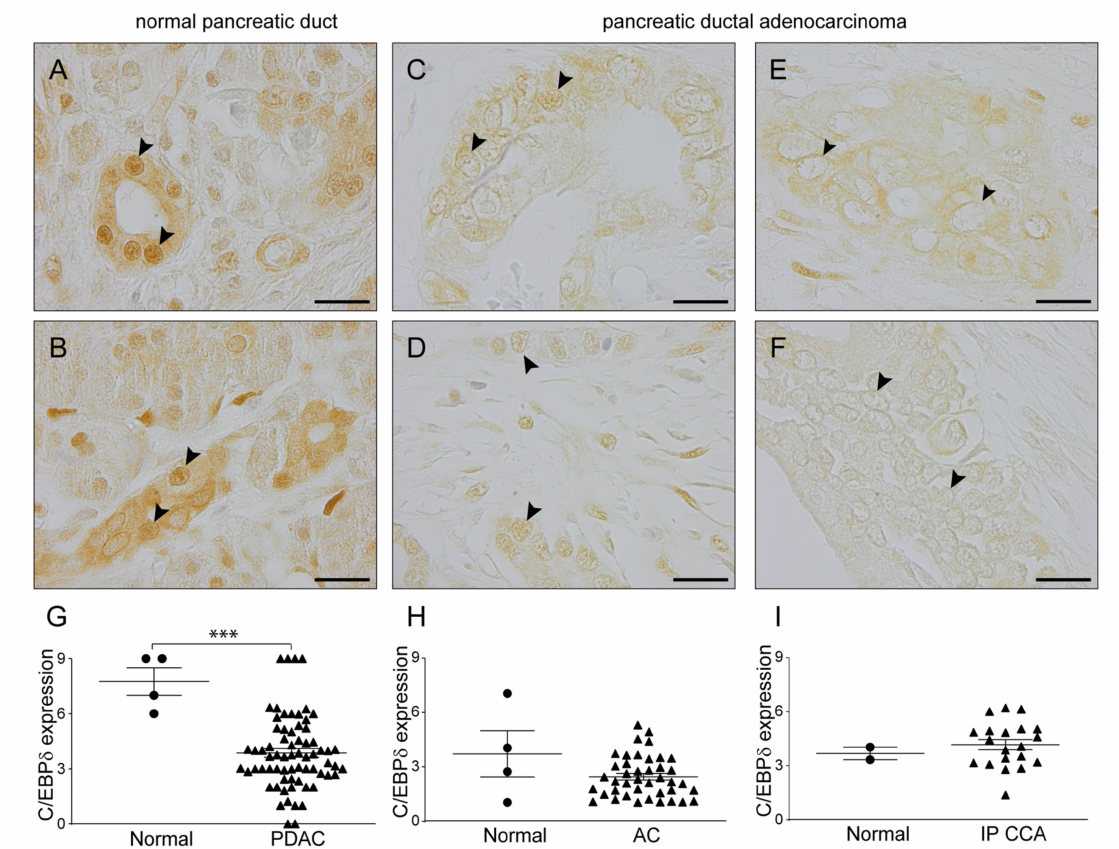
Figure 2. C / EBP δ expression is decreased in the nuclei of pancreatic ductal adenocarcinoma cells. Immunohistochemical staining of C / EBP δ shows strong expression in healthy pancreatic tissue ( A , B ) and decreased ( C , D ) or no expression ( E , F ) in pancreatic ductal adenocarcinoma. Representative tumor nuclei are indicated with black arrowheads. Quantification of nuclear C / EBP δ expression levels in healthy control tissue ( G – I ), pancreatic ductal adenocarcinoma ( G ), ampullary carcinoma ( H ) and intrapancreatic cholangiocarcinoma ( I ). *** p < 0.001 compared to healthy control tissue. Lines indicate the mean ± SEM. PDAC: pancreatic ductal adenocarcinoma, AC: ampullary carcinoma, IP CCA: intrapancreatic cholangiocarcinoma. Scale bars: 20 µ